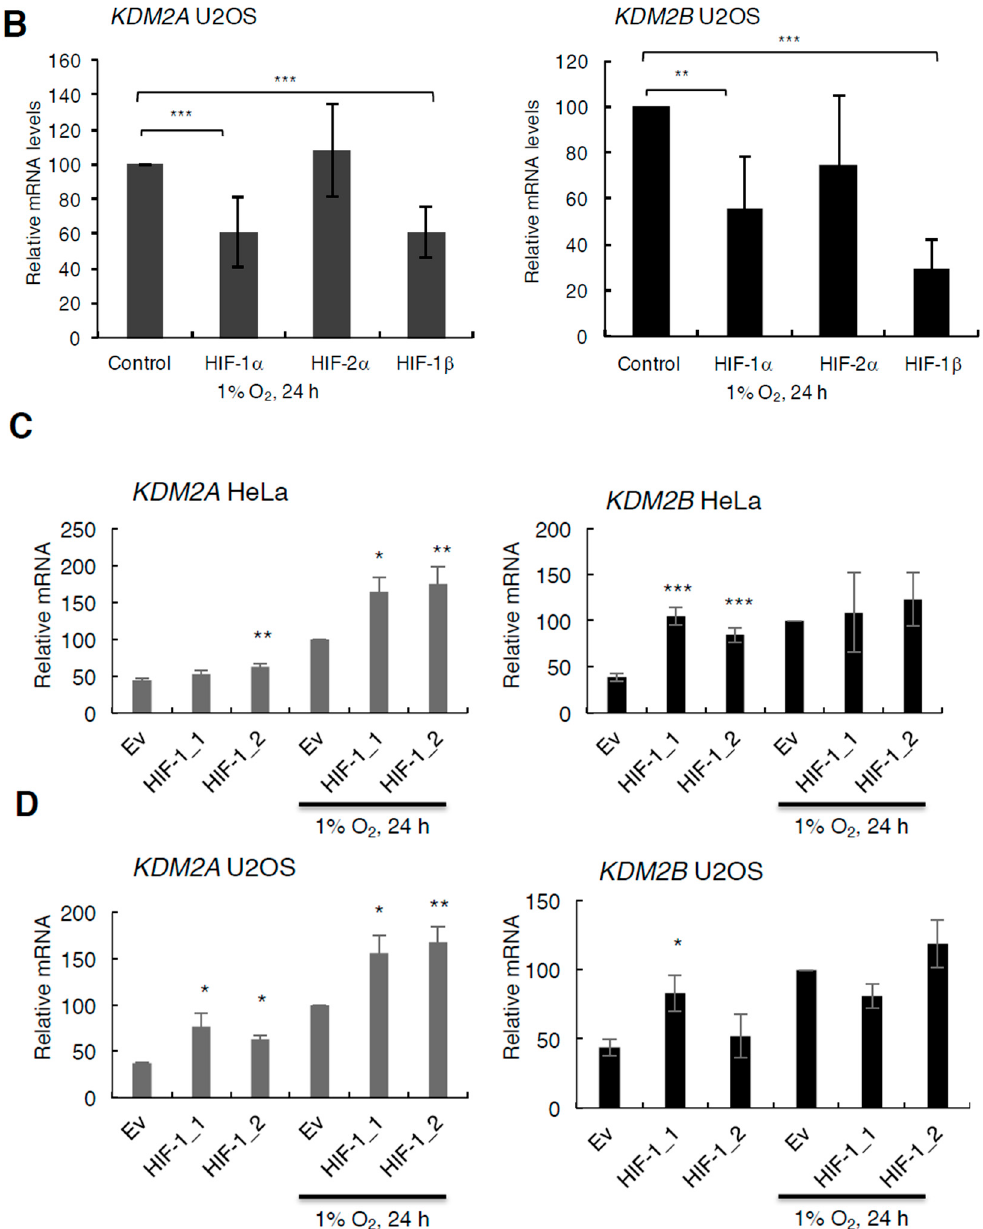
Figure 4. Hypoxia-induced KDM2A and KDM2B mRNA in a HIF- α /HIF-1 β -dependent manner. ( A